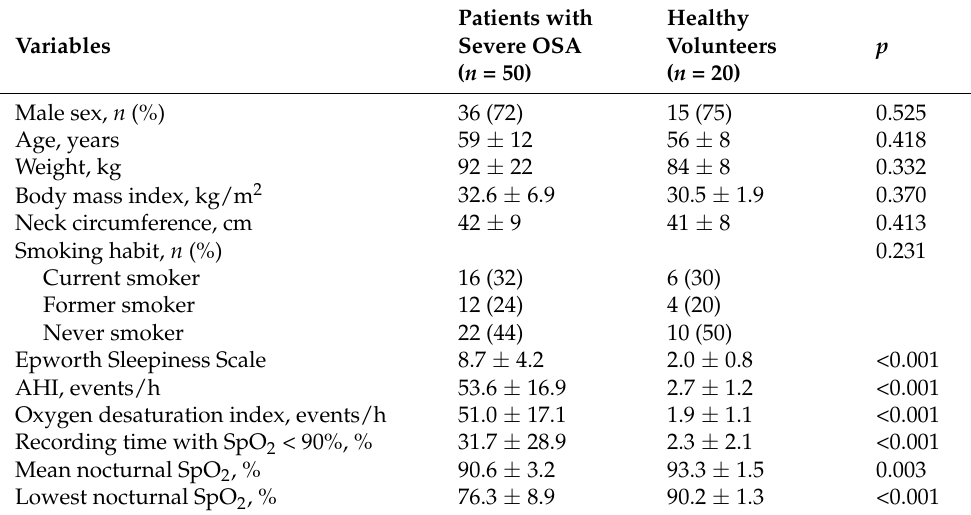
Table 1. General characteristics of the study participants *.